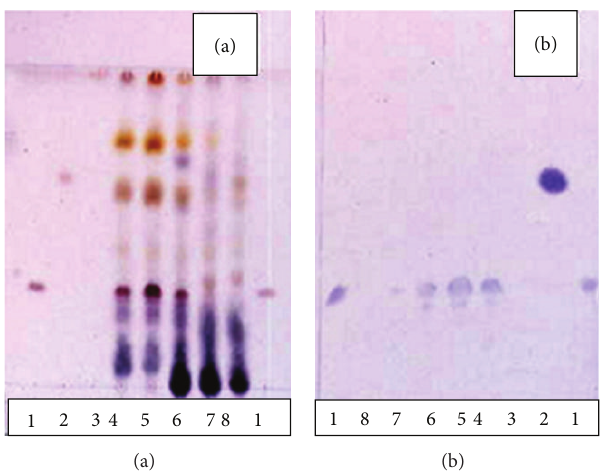
Figure 3: Chromatographic fingerprintings of TCM prescribed licorice, Glycyrrhiza species, standard of glycyrrhizin, and glycyrrhetic acid O-glucuronide by eastern blotting using antiglycyrrhizin MAb (b) and TLC stained by H 2 SO 4 (a). 1: glycyrrhizin, 2: glycyrrhetic acid O- glucuronide, 3: glycyrrhetic acid, 4: G. uralensis , 5: G. glabra , 6: Shaoyao Gancao Tang, 7: Xiao Chaihu Tang, 8: Da Chaihu Tang.